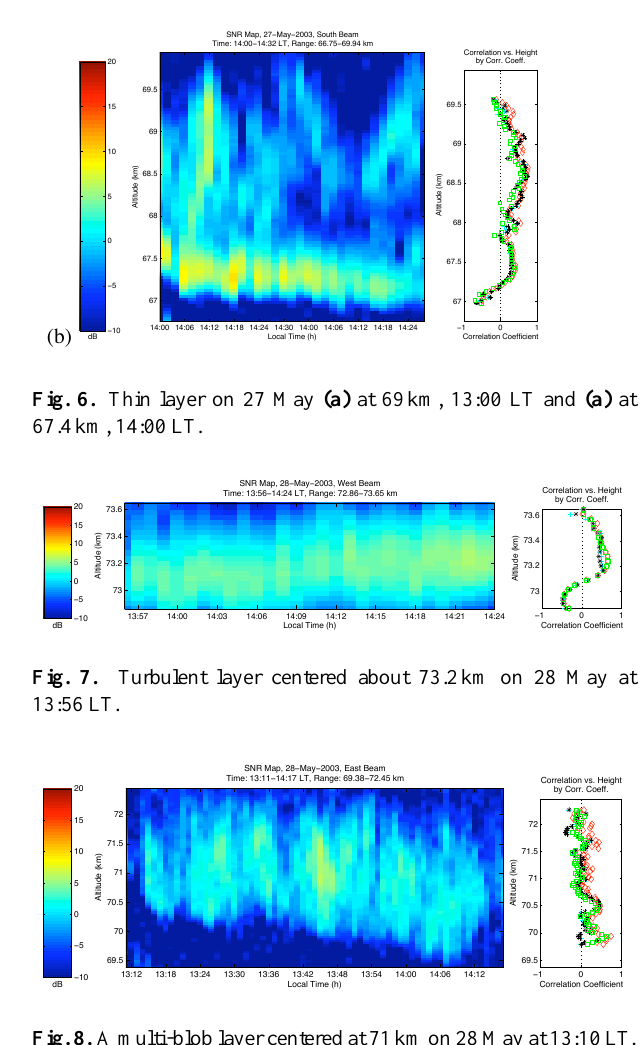
Fig. 7. Turbulent layer centered about 73.2 km on May 28 at 13:56 LT.